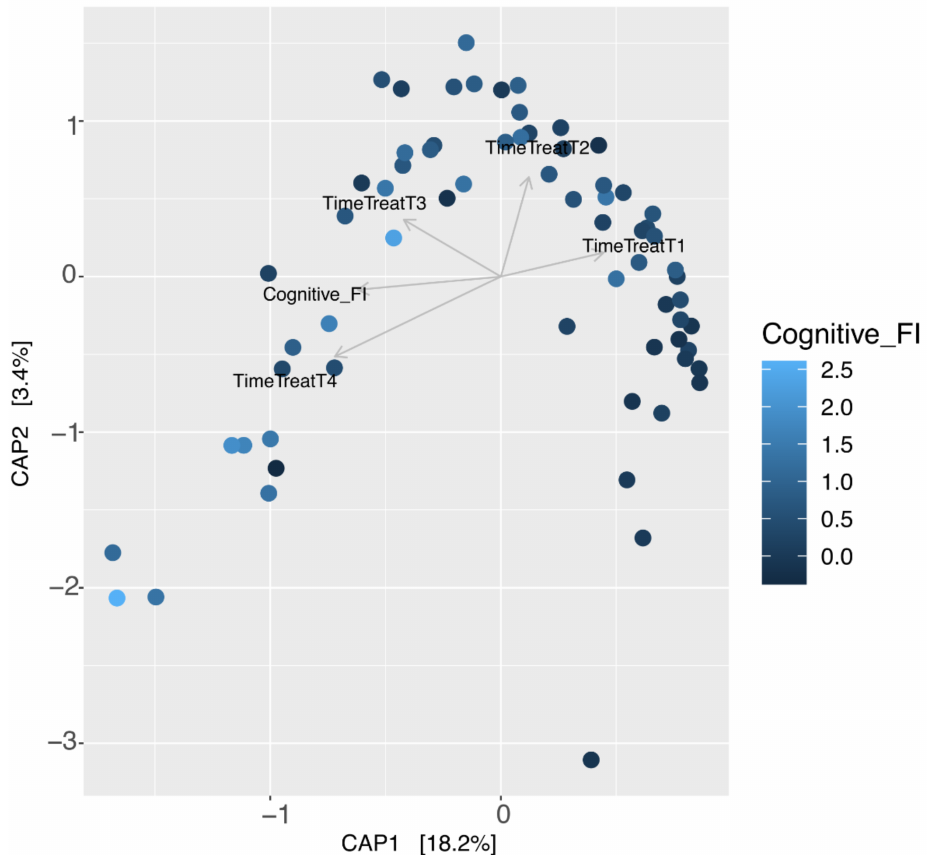
Figure 9. CAP analysis revealed that microbiomes varied by time, but with a slight effect on the Cognitive Frailty Index. CAP analysis was performed using the beta diversity based on Bray-Curtis distance metric constrained to time point and Cognitive FI. Each dot represents each sample’s coordinate on constrained PCoA1. Different levels of Cognitive FI are reported as a gradient scale (lower values in dark blue and higher values light